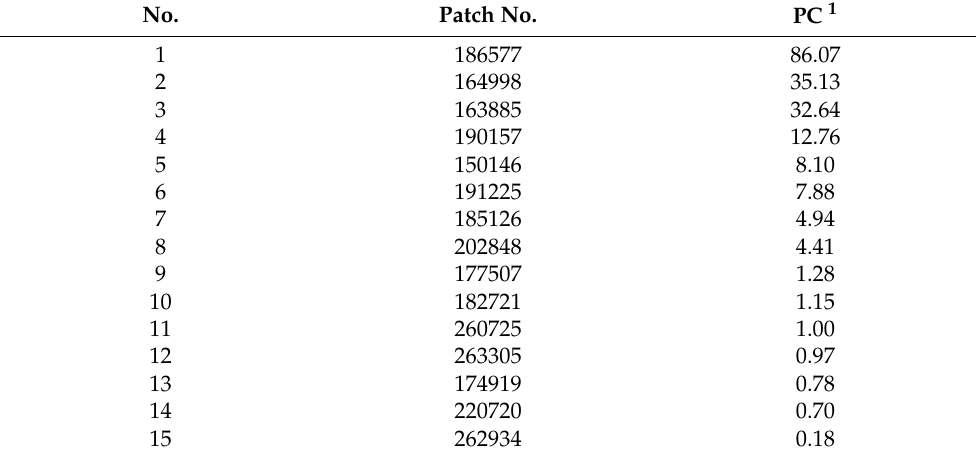
Table 3. Calculation results of landscape connectivity in the core area. No. Patch No.